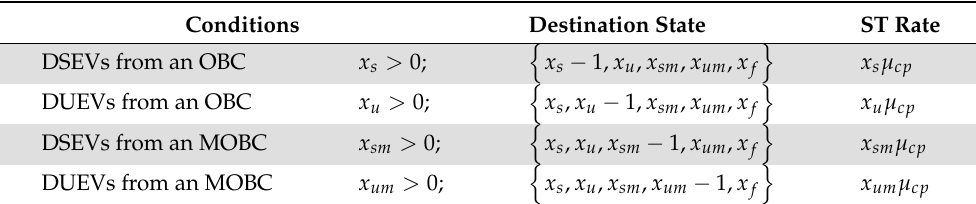
Table 3. STs from x triggered by EV